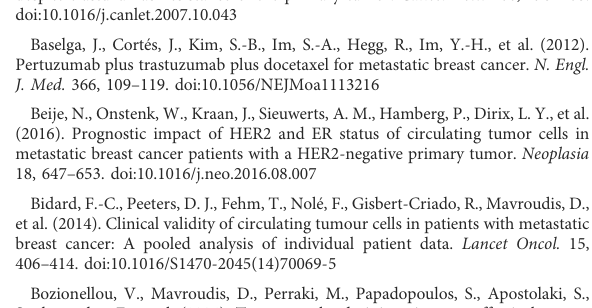
** p = 0.0025 (two-tailed) indicated a positive, strong correlation at a signi fi cant level. SUPPLEMENTARY FIGURE S4 Receiver operating characteristic (ROC) curve analysis of CTC enumeration by Pep@MNPs used to detect breast cancer. Fifty-two breast cancer patients and 10 healthy donors were totally included to achieve CTC enumeration by Pep@MNPs and immunocytochemistry. Healthy donors served as controls for assessing the speci fi city. The area under curve (AUC) (gray) was 0.875 ( p = 0.0002). The black arrow indicates the cutoff with the maximized Youden index (i.e. 3CTCs per 2.0 mL whole blood), which could beused to identify breast cancer patients ( ≥ 3 CTCs) sensitively and speci fi cally. The detailed information from the ROC analysis is included in supplemental material (Supplementary Table S2). SUPPLEMENTARY FIGURE S5 CTC number distribution in two subgroups of patients with non-visceral (n = 17) or visceral metastases (n = 35). Data are presented as scattered dots, together with means ± SD. p = 0.022, unpaired Student ’ s t-test with Welch ’ s correction. SUPPLEMENTARY FIGURE S6 ROC analysis of the HER2(2+) CTC ratio used to differentiate the patients with various IHC-based HER2 status (IHC++ vs IHC+/0). Area under curve (AUC) was calculated as 0.755 (p = 0.021). Black arrow indicated the cutoff (12%) of the ratio of HER2(2+) CTCs with maximized Youden index, with moderate sensitivity (58.3%; 95% con fi dent interval (CI), 32.0% – 80.7%) and high speci fi city (100%; 95% CI, 81.6% – 100%). SUPPLEMENTARY FIGURE S7 Representative cases with a good concordance between the HER2 expression on CTCs and on tumor tissues at baseline, including patient #18 (A) and #51 (B) . Cell nuclei (blue) and HER2 proteins (brown) were visible due to immunochemical reactions on tumor tissues. SUPPLEMENTARY FIGURE S8 Correlation analysis of pretherapeutic CTC enumeration with progression-free survival (PFS) (A) and overall survival (OS) (B) of non- HER2+ patients. Patients with various CTC enumeration ( ≥ 3 CTCs in pink; > 3 CTCs in gray) from 2.0 mL whole blood at baseline were compared. Log-rank test was used to assess the differences. p < 0.05, not signi fi cant (ns). N/A, median OS not yet reached. SUPPLEMENTARY FIGURE S9 HER2 phenotyping of the enriched CTCs improves the prediction of survivals in HER2+ breast cancer. (A,B) Kaplan-Meier plots of progression-free survival (PFS) (A) and overall survival (OS) (B) in the patients with various CTC enumeration ( ≥ 3 CTCs in pink; > 3 CTCs in gray)from2.0mLwholebloodatbaseline.InPFS (A) ,log-rank p =0.168; in OS (B) , log-rank p = 0.219; both are > 0.05 (not signi fi cant, ns). (C,D) Kaplan-Meier